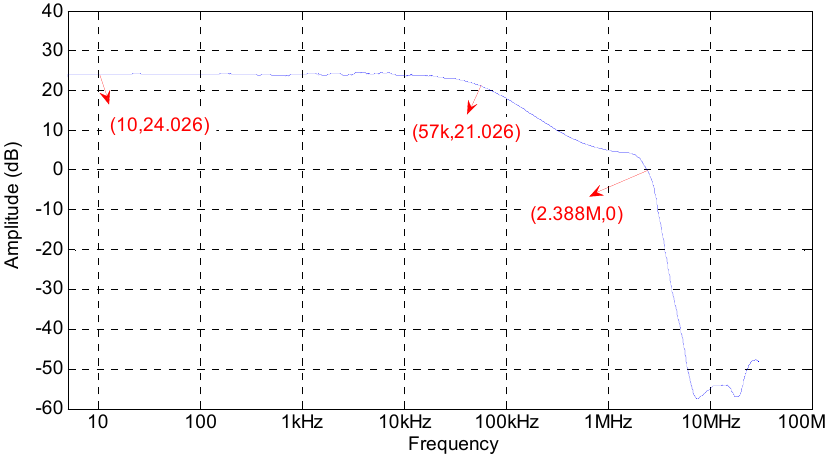
Figure 19. Measured frequency–amplitude characteristic.